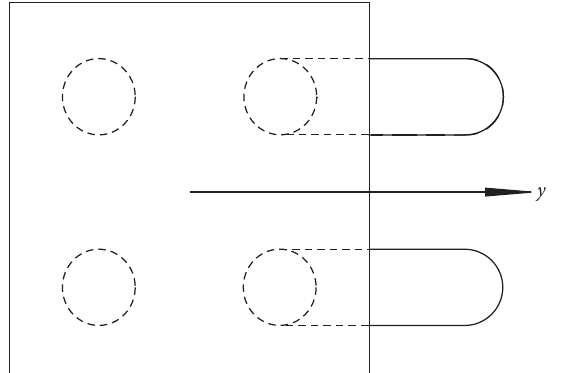
Figure 11: Plan layout of pile